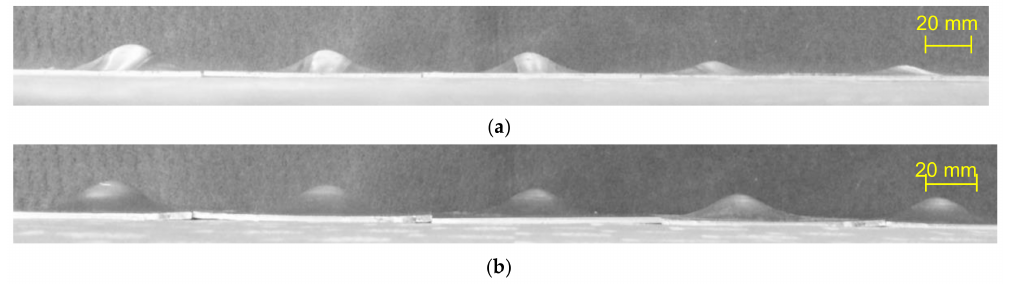
Figure 7. Samples deformed by means of hemispherical punch test: ( a ) FSWed+CRed and ( b ) BM+CRed samples.